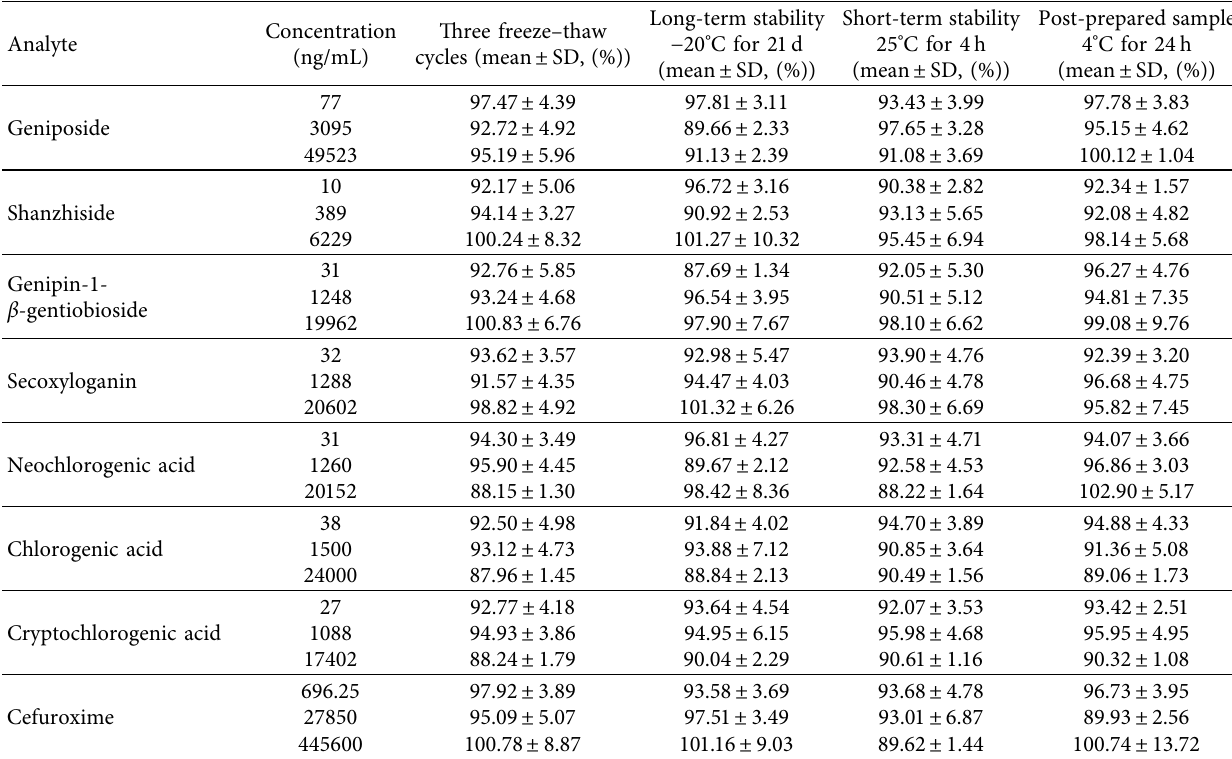
Table 5: The stabilities of seven analytes with cefuroxime of QC samples in rat plasma under different storage conditions.